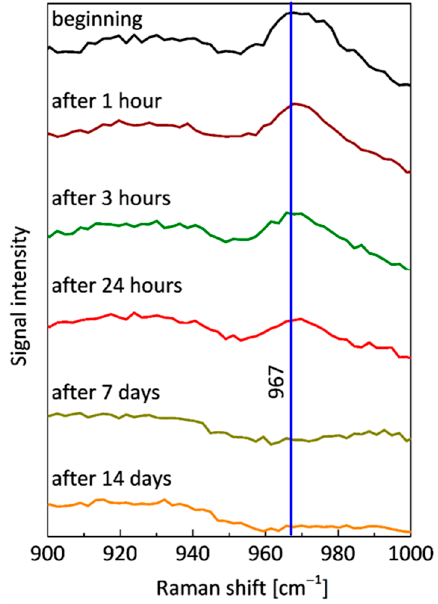
Figure 11. Selected Raman spectra of the tested bone taken for the first 24 h and 14 days—the spectrum taken at the beginning of the experiment (the bone has not been put at the acetic acid influence) and subsequently after 1 h, after 3 h, after 24 h, after 7 days and after 14 days.